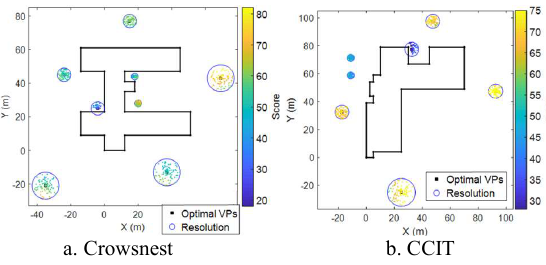
Figure 10. Heatmaps of 100 random solutions